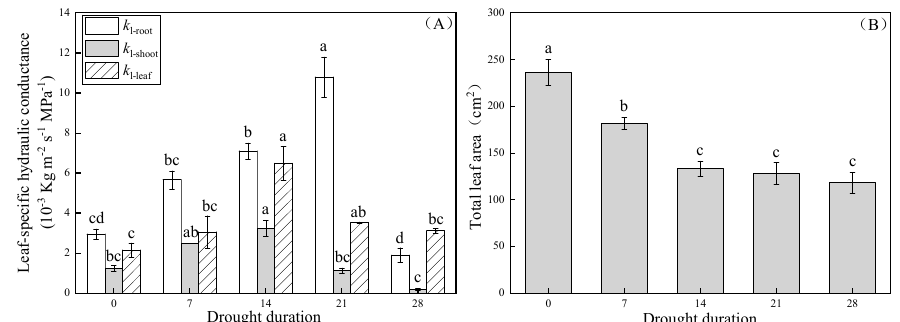
Figure 4. Changes in leaf-specific hydraulic conductance ( A ) and the total leaf area ( B ) in drought treatments. ( A ): k l-root (open bars) indicate leaf-specific hydraulic conductance of whole roots, k l-shoot (light-shaded bars) indicate leaf-specific hydraulic conductance of whole shoots, k l-leaf (hatched bars) indicate leaf-specific hydraulic conductance of leaves. Different lower-case letters denote significance levels based on analysis of variance (ANOVA) post hoc means with least significant di ff erence (LSD) analysis ( p < 0.05). Data are means with standard error.